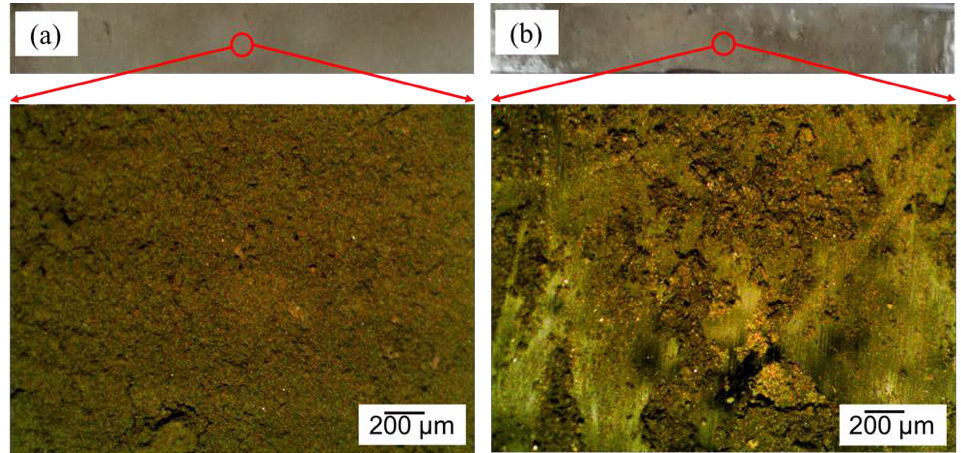
Figure 9. Stereophotographs of the sintered thin-film of Ag-NPs supported on the PDMS substrate, ( a ) before and ( b ) after stretching.